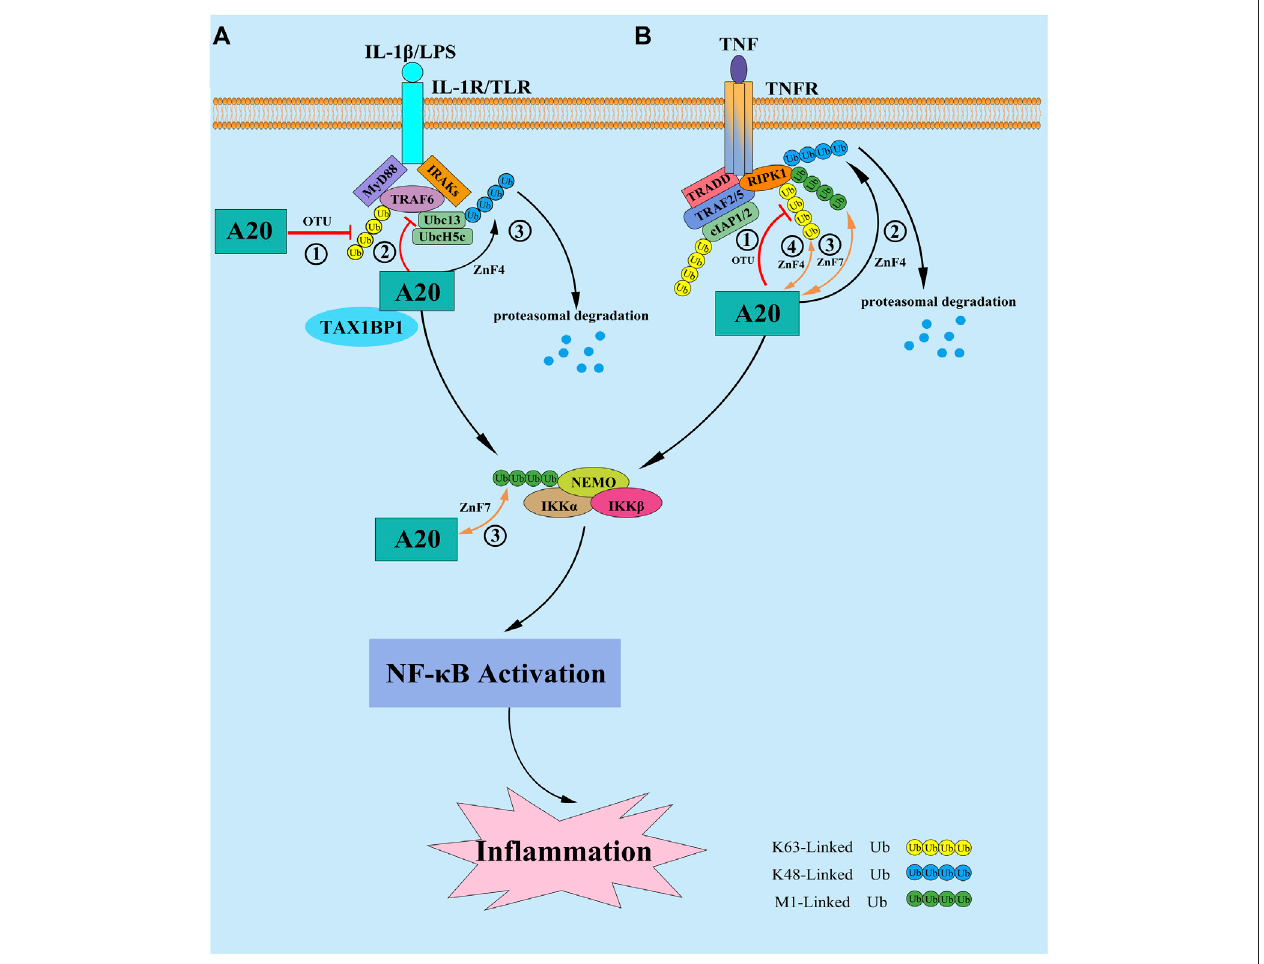
FIGURE1| (A) InresponsetoIL-1 β and/or LPSstimulation,A20expressionisinducedandinhibittheNF- κ Bsignalinginanegativefeedbackloop. ① A20directly target the E3 ligase TRAF6 by disassembling the K63-Linked polyubiquitin chains of TRAF6 via its OTU domain; ② A20 disrupt the interactions between TRAF6 and its E2 enzymes Ubc13 and UbcH5 cooperating with the ubiquitin-binding adaptor molecule TAX1BP1 in the fi rst step; ③ then at later times A20 conjugate K48-Linked polyubiquitin chains on Ubc13 and/or UbcH5c via its ZnF4 domain to trigger their proteasomal degradation. (B) In response to TNF stimulation, A20 is reported to inhibittheNF- κ Bsignaling bythefollowingmechanisms: ① A20hydrolyze theK63-Linkedpolyubiquitin chainsofRIPK1 via its OTUdomain tosupressthedownstream activation of IKK complex, as well as the NF- κ B signaling; ② A20 conjugate K48-Linked polyubiquitin chains on RIPK1 via its ZnF4 domain to trigger its proteasomal degradation; ③ A20 bind to the M1-Linked polyubiquitin chains of RIPK1 and/or NF- κ B essential modulator (NEMO) through its ZnF7 structural domain, to stabilize the M1-Linkedpolyubiquitinchainsandprotectthemfromproteasomaldegradation,thusaffectingtheactivationoftheIKKcomplexinanon-catalyticpathway; ④ A20bind to the K63-Linked polyubiquitin chains of RIPK1 through the ZnF4 domain, which is largely dispensable for restricting NF- κ B signaling.